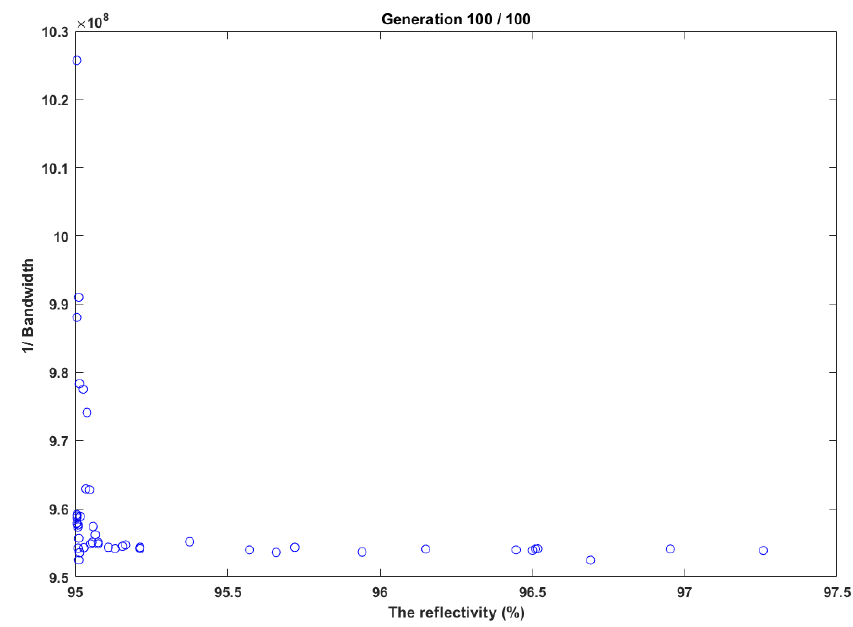
8 of 14 Table 1. The testing parameters of optimization. Parameter